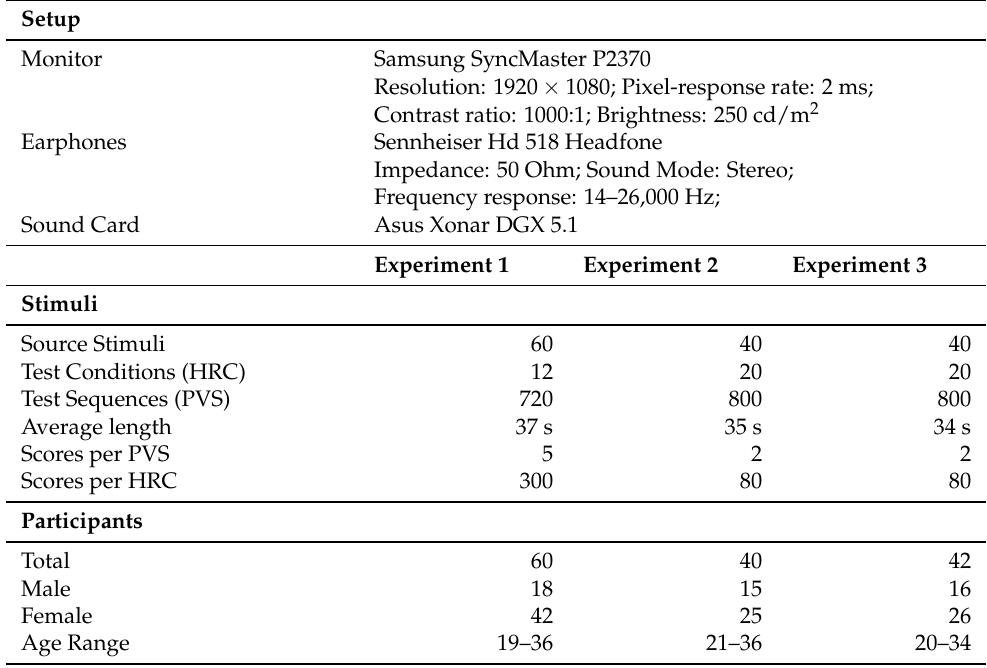
Table 6. Detailed specifications of the Experiments